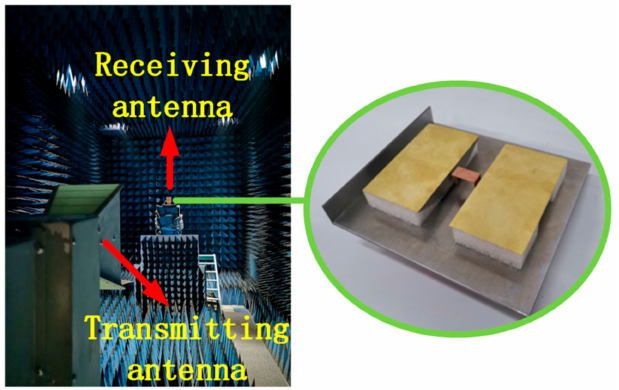
Figure 9. The measurement of proposed antenna.